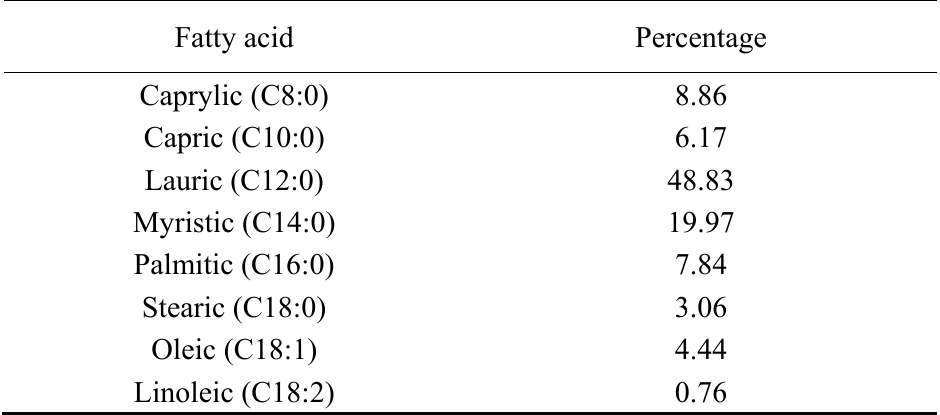
Table 2. Fatty acid methyl esters (FAME) composition of coconut oil-based